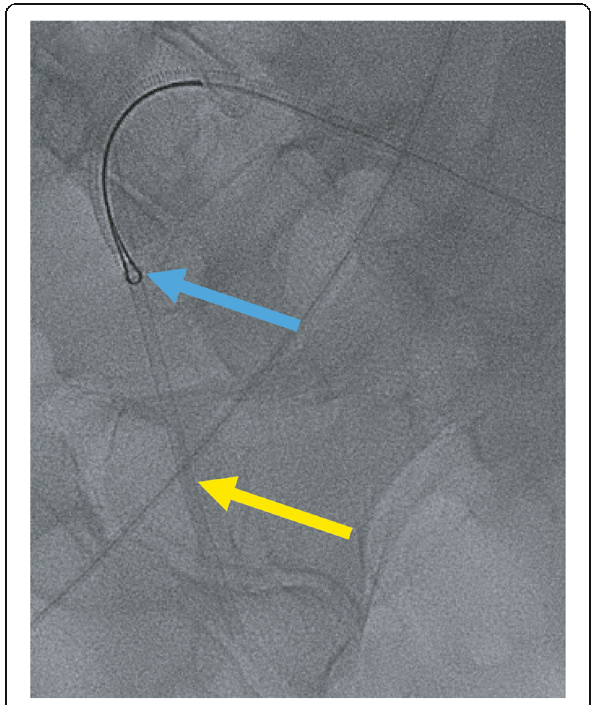
Fig. 1 Initial fluoroscopic image showing the sheath fragment trapped within the right common femoral artery (yellow arrow)